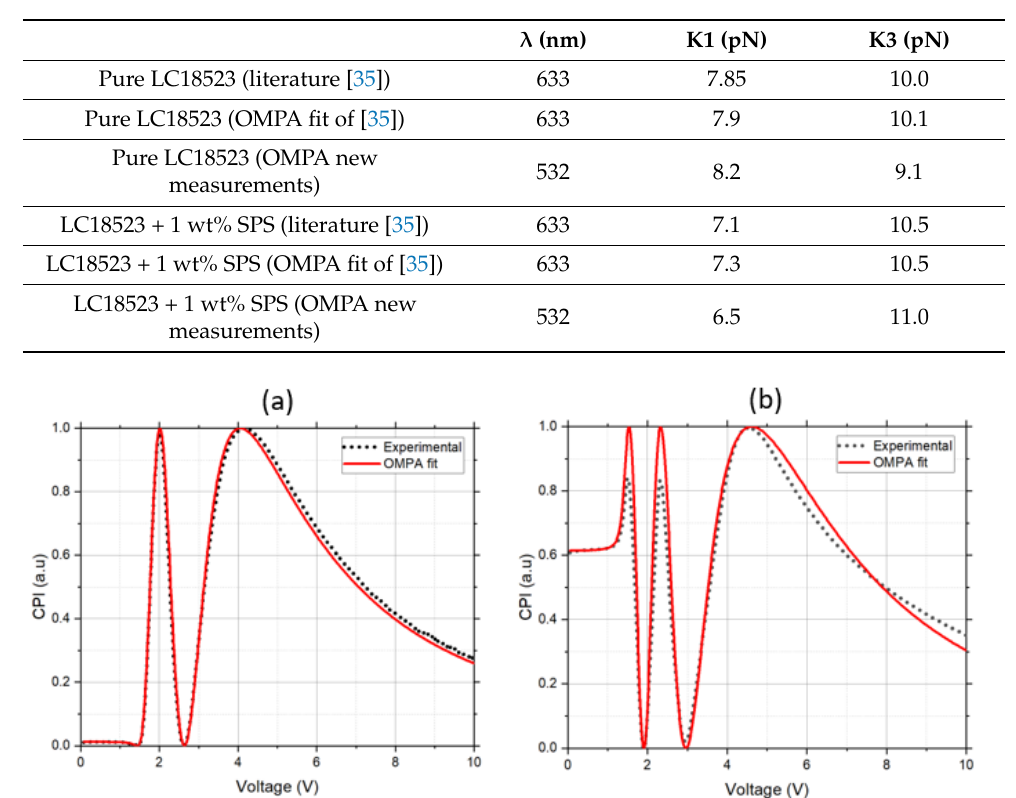
Table 2. Summary of elastic constants obtained by the OMPA through the fitting of CPIs from cells filled with pure and nanoparticle-doped LC18523. These cells were measured using light illumina- tion at 633 nm and 532 nm.